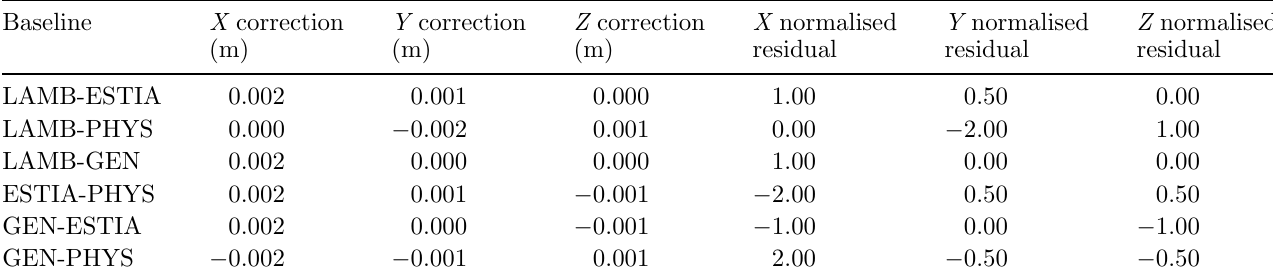
Table 9. Local test performed in baseline components (minimally constrained solution). Baseline